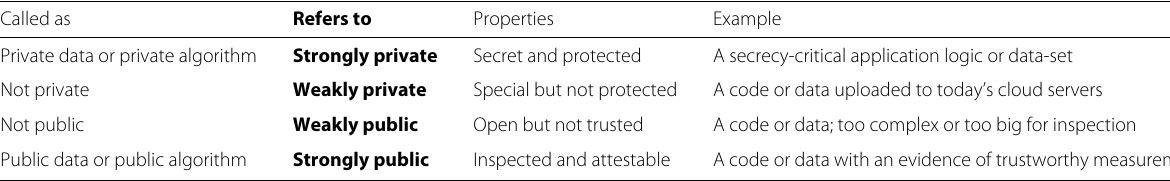
Table 1 Definition of the private and public